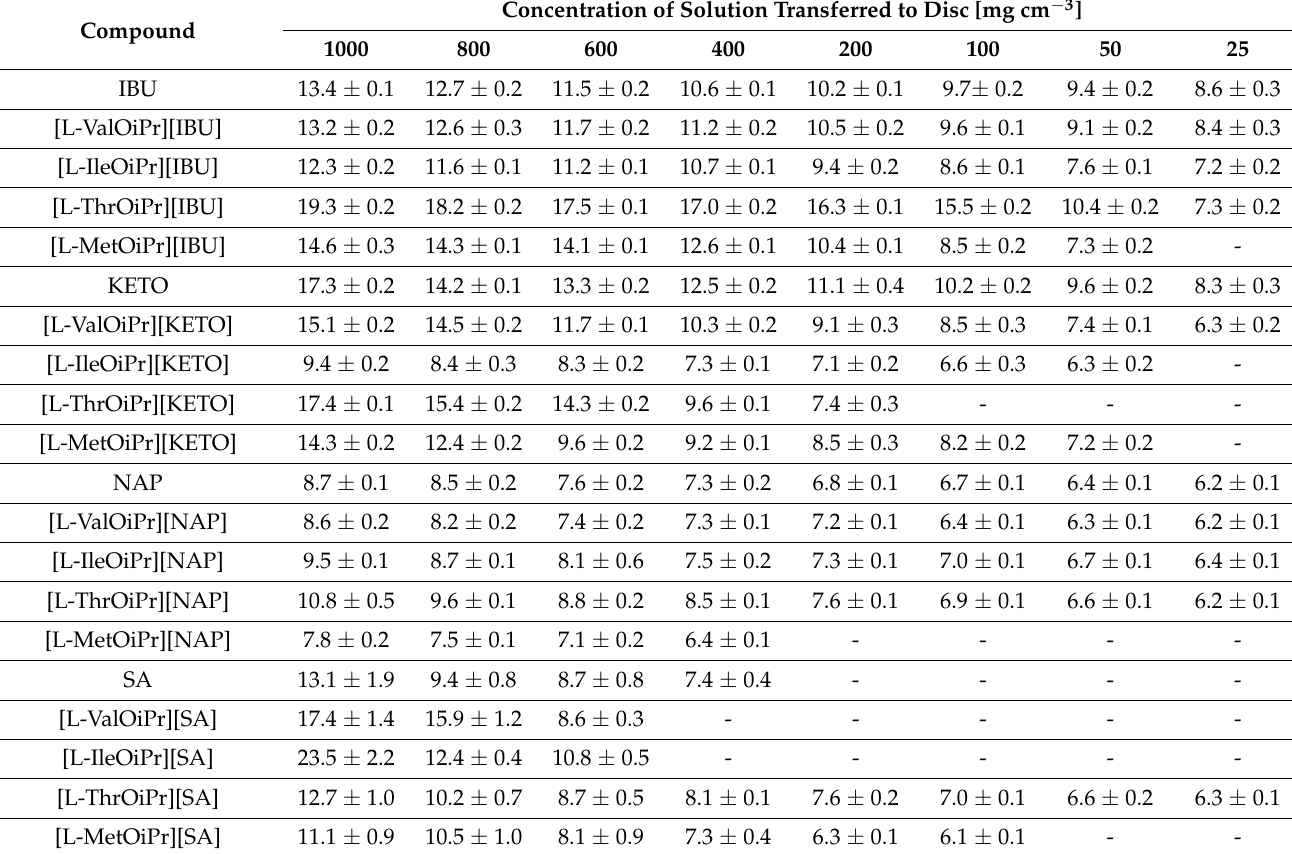
Table 8. Antimicrobial activity against Micrococcus Luteus of acids from NSAIDs and their L-amino acid isopropyl ester salts, Inhibition diameter